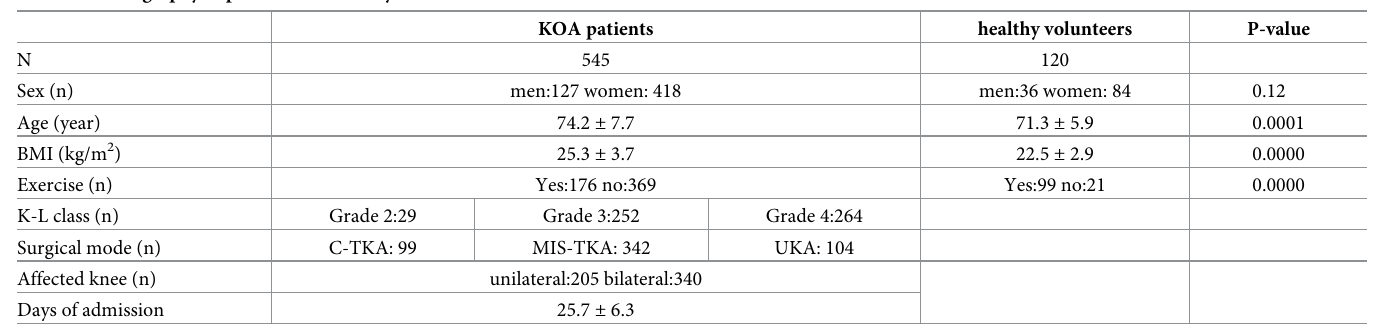
Table 1. Demography of patients and healthy